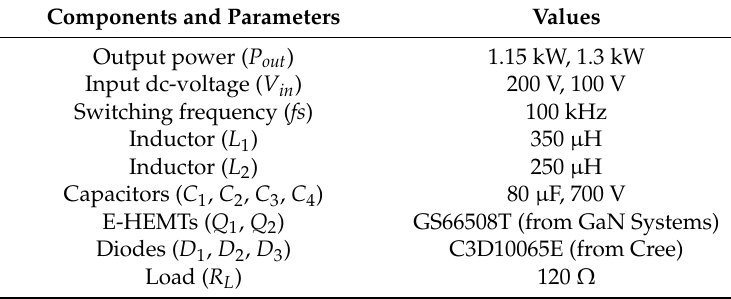
Table 3. Main Experimental Parameters of the Proposed Converter.